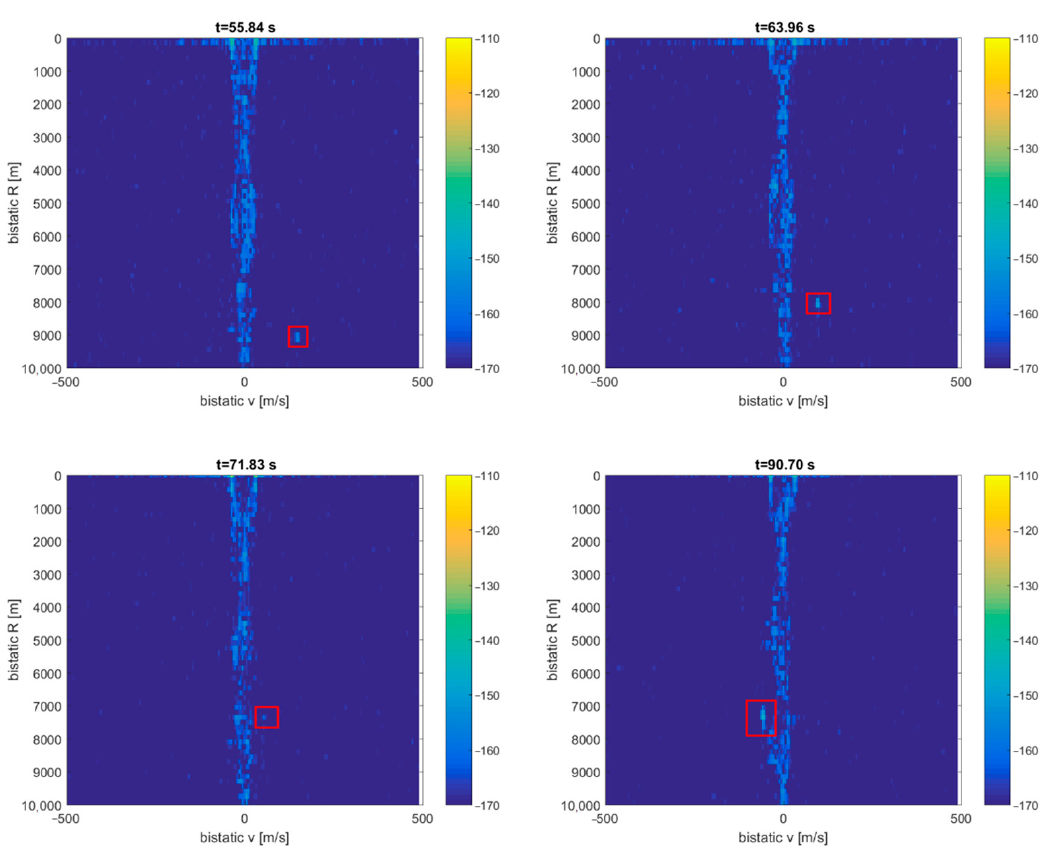
Figure 23. Detection results of the THY9 airplane (subsequent time stamps).